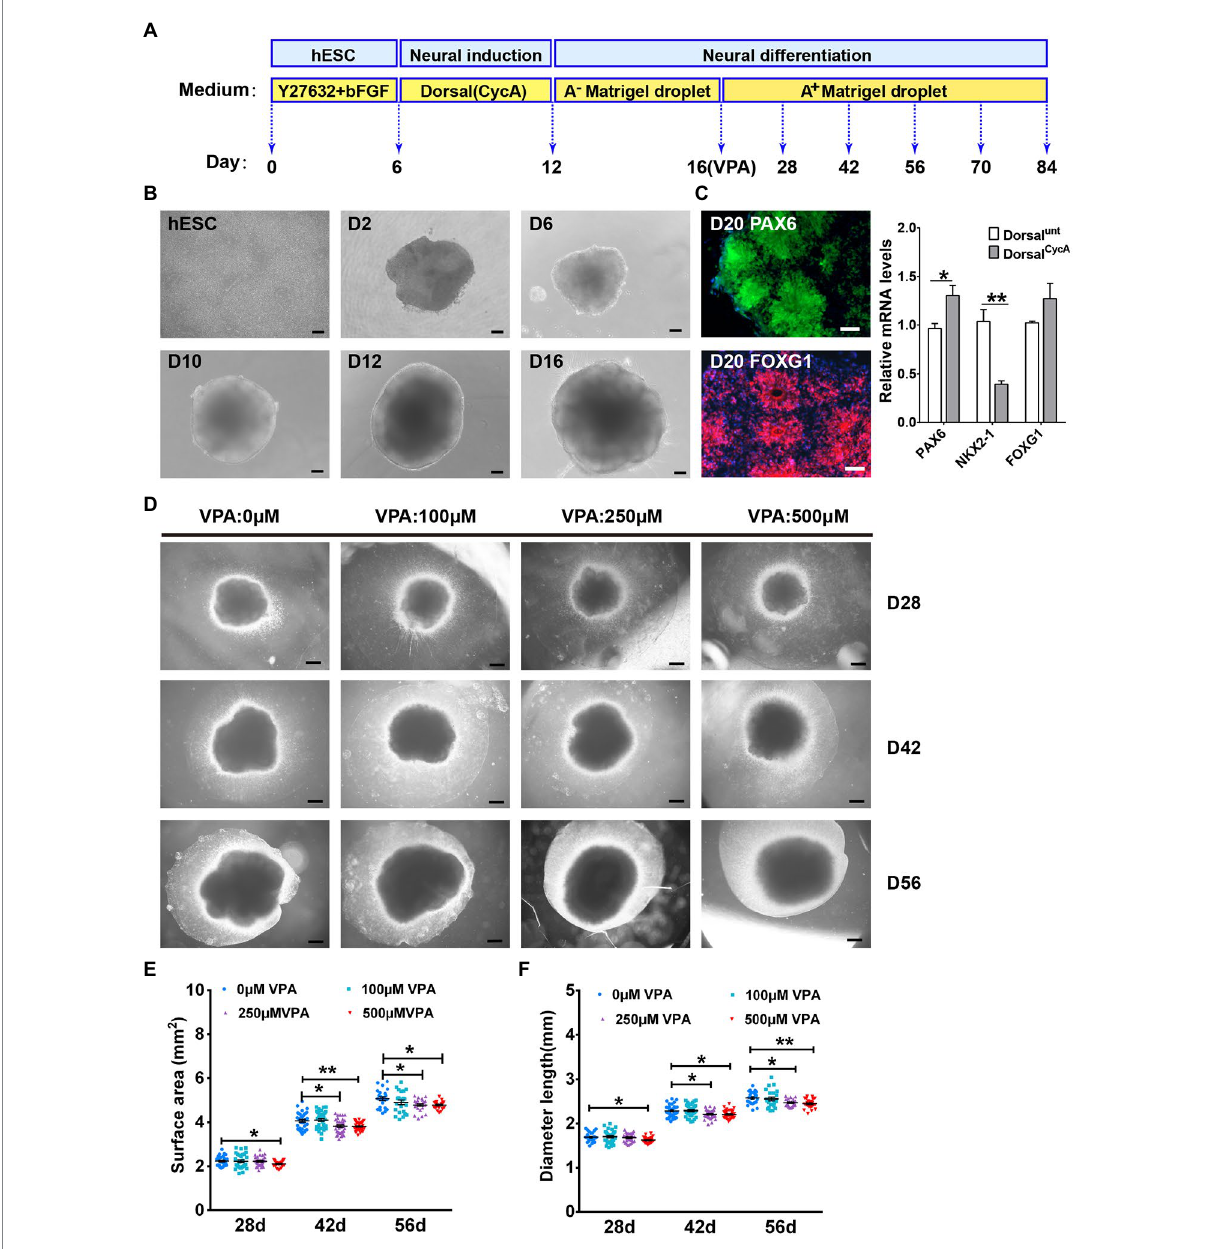
FIGURE 1 VPA exposure inhibited the expansion in human dorsal forebrain organoids. (A) A schematic diagram illustrating the procedures for producing dorsal forebrain cerebral organoids from human hESCs. (B) The organoids exhibited large neuroepithelial loops and the overall organoid sizes consistently increased over time. Scale bars, 100 μ m. (C) The organoids exhibited a dorsal forebrain identity at day 20 ( n = 3 organoids each). Scale bars, 50 μ m. (D) Representative pictures from control and VPA treated cerebral organoids at days 28, 42, and 56. Scale bars, 500 μ m. (E,F) The growth of dorsal cerebral organoid from day 28 to day 56 were further assessed using surface area (E) and diameter (F) at day 28 ( n = 29 organoids each), 42 ( n = 34 organoids each), and 56 ( n = 23 organoids each). * p > 0.05, ** p >